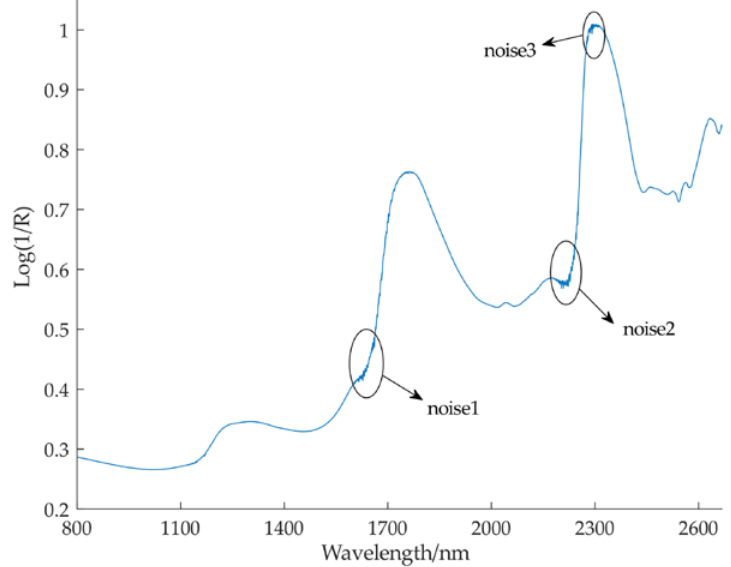
Figure 3. The average spectrum of L0. Note: L0 refers to the original spectrum, which has three distinct areas of noise around 1600, 2200, and 2400 nm here (defined as noise1, noise2, and noise3, respectively).